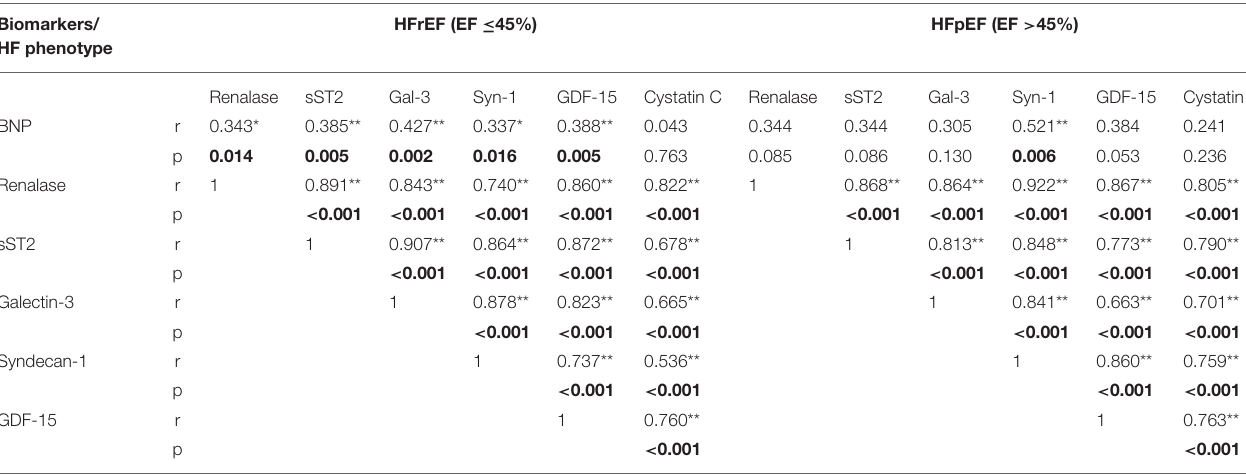
TABLE 2 | Correlation coefficients between renalase and biomarkers with regard to the ejection fraction. Biomarkers/ HF